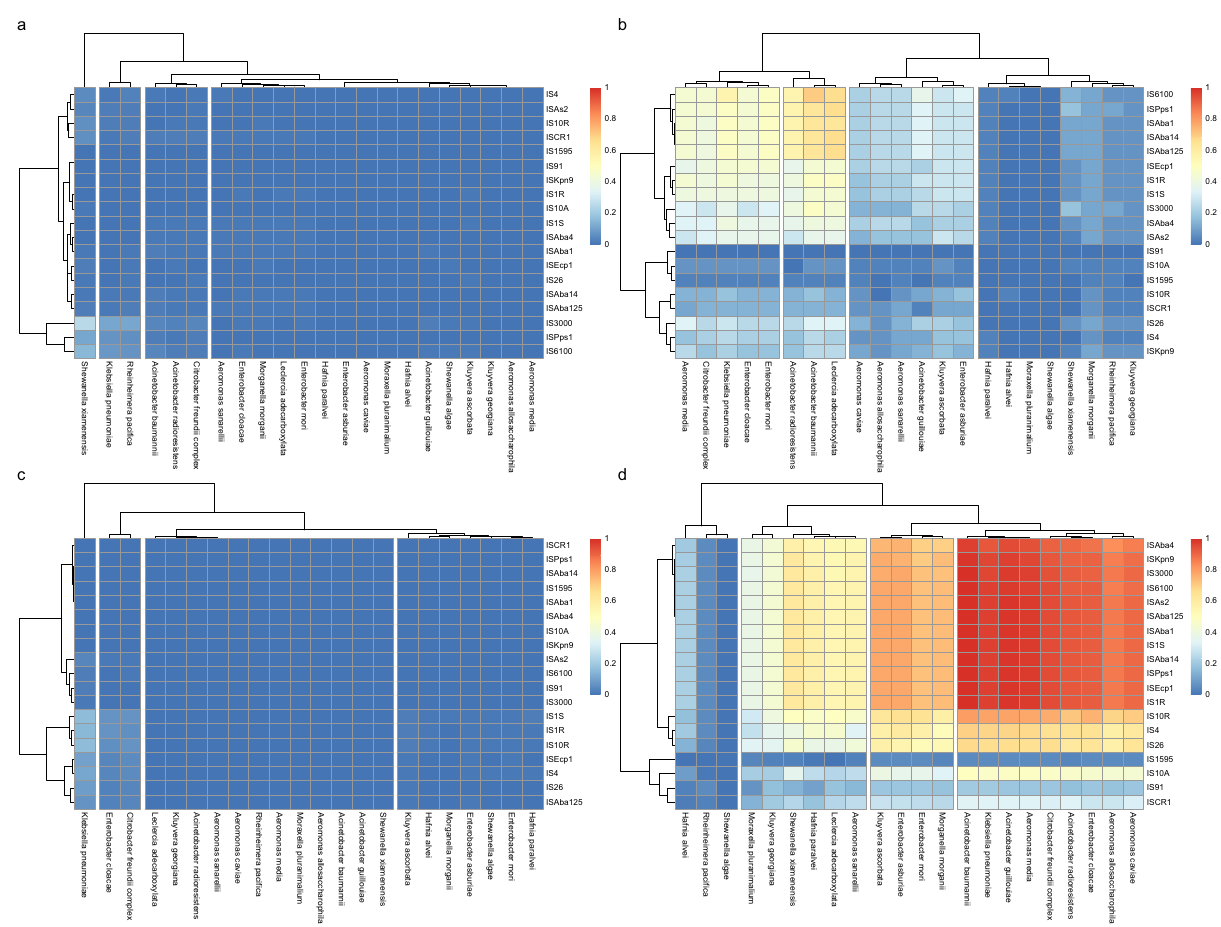
Fig. 4 Co-existing origin species and mobilizing IS elements. Fractions of samples that contained both an origin species and an IS elements involved in mobilization (MISE) for the following subsets of data, ( a ) combined soil and water environments where no crAssphage was detected ( n = 391), ( b ) combined soil and water environments with detectable levels of crAssphage ( n = 22), ( c ) human stool ( n = 384), ( d ) in fl uent of wastewater treatment plants ( n =